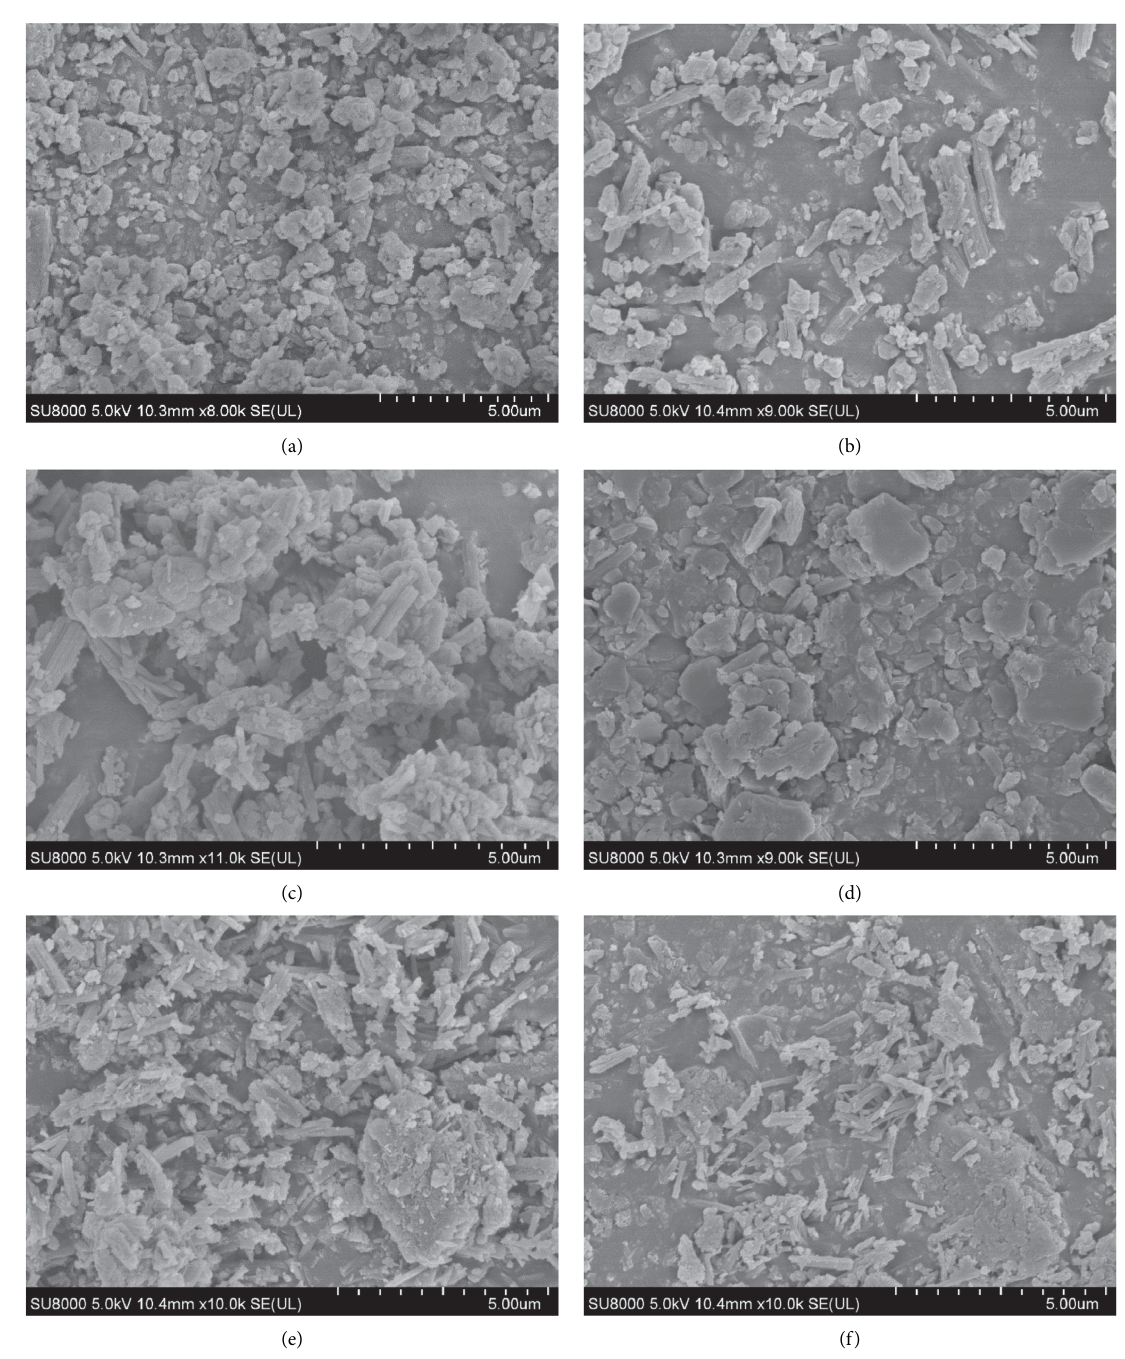
Figure 7: SEM images of the morphology of formed precipitates with the added chemical dosage at Ca: S molar ratios of (a) 2 :1, (b) 3:1, (c) 4:1, and (d) 6:1, respectively, when the molar ratio of Al :S is 2:1; and (e) and (f) present the SEM images of precipitates formed with the chemical dosage of Al :Ca: S at 0.8:4 :1 and 1:4 :1,